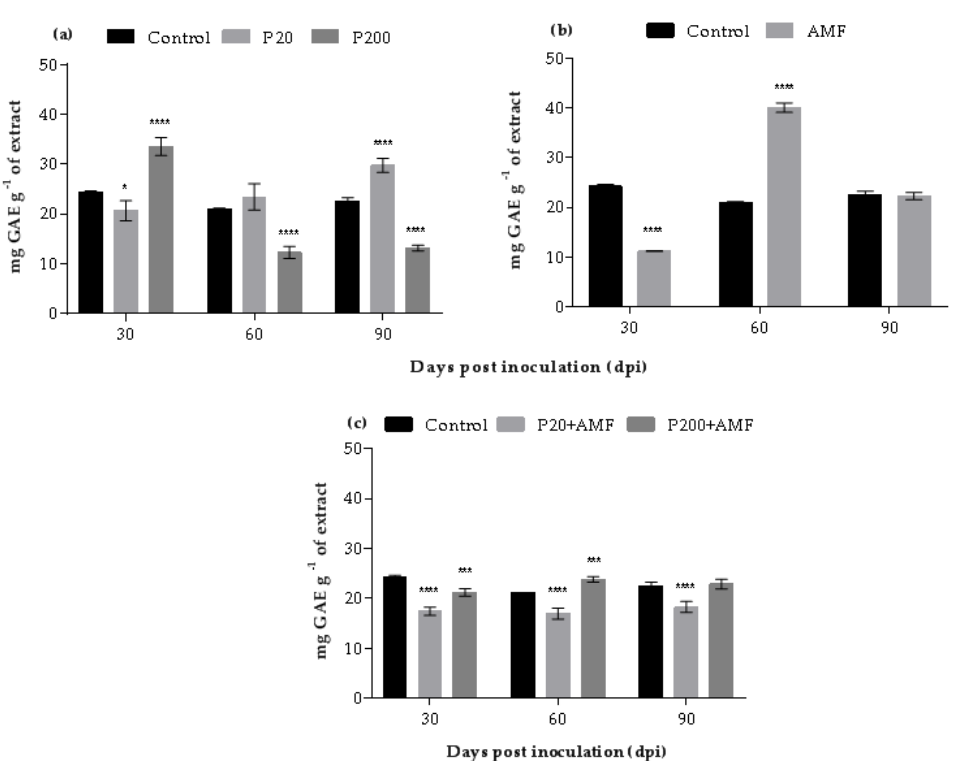
Figure 3. Variation of phenolic compounds produced by Piper divaricatum : ( a ) plants treated with 20 and 200 mg of P · dm − 3 of soil (P20 and P200); ( b ) plants inoculated with AMFs (AMF); ( c ) plants inoculated with AMFs and treated with 20 and 200 mg of P · dm − 3 of soil (P20 + AMF and P200 + AMF). Statistical difference according to Bonferroni test ( p < 0.05). Significance level: **** extremely signifi- cant ( p < 0.0001), *** very significant ( p < 0.001), * low significance ( p < 0.1).